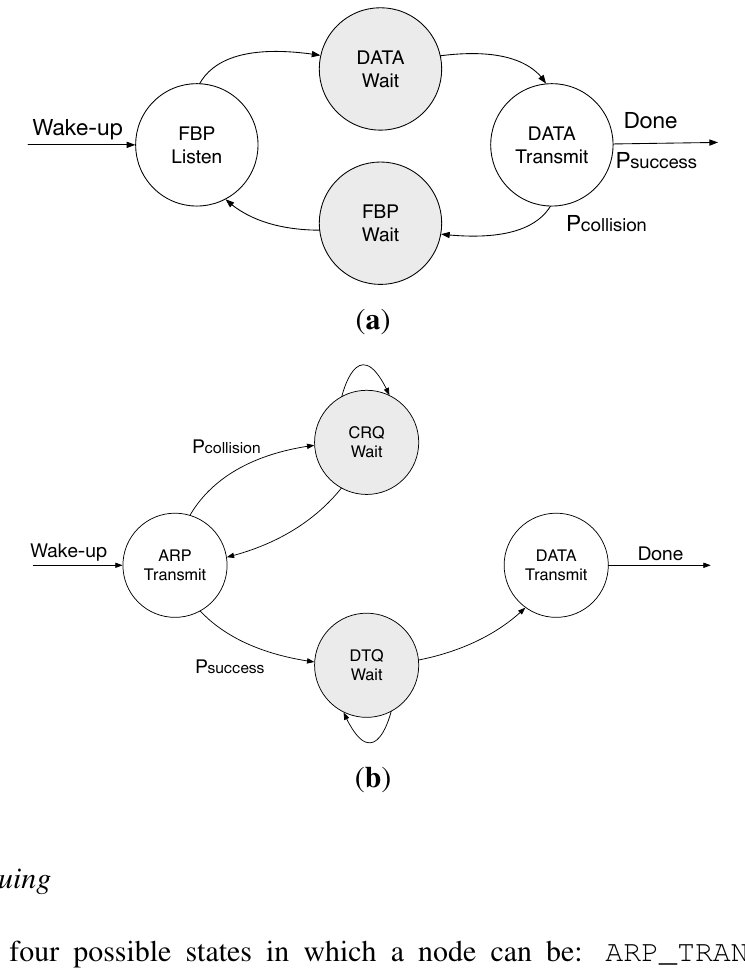
Figure 3. Frame Slotted ALOHA (FSA) and Distributed Queueing (DQ) states. ( a ) Frame Slotted ALOHA (FSA) states; ( b ) Distributed Queuing (DQ)